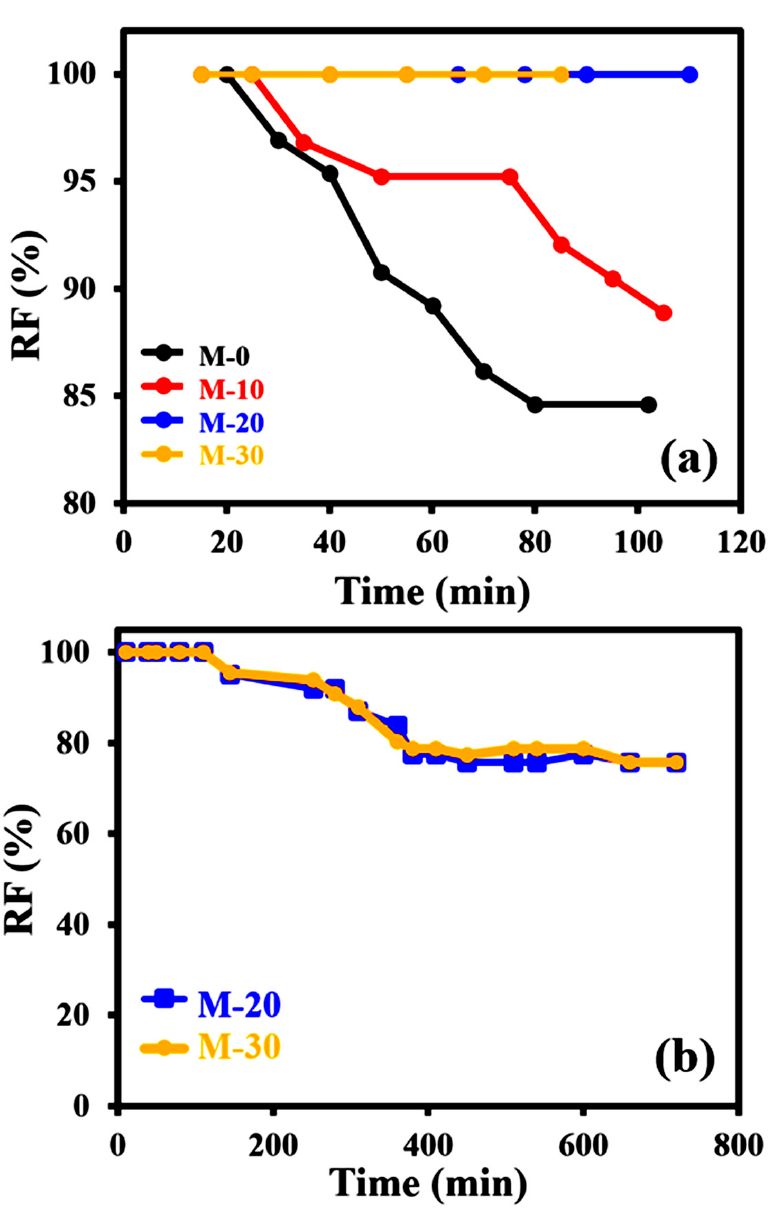
Figure 10. ( a ) Relative flux of all membranes after fouling by humic acid and ( b ) stability of M-20 and M-30 over 12 h.